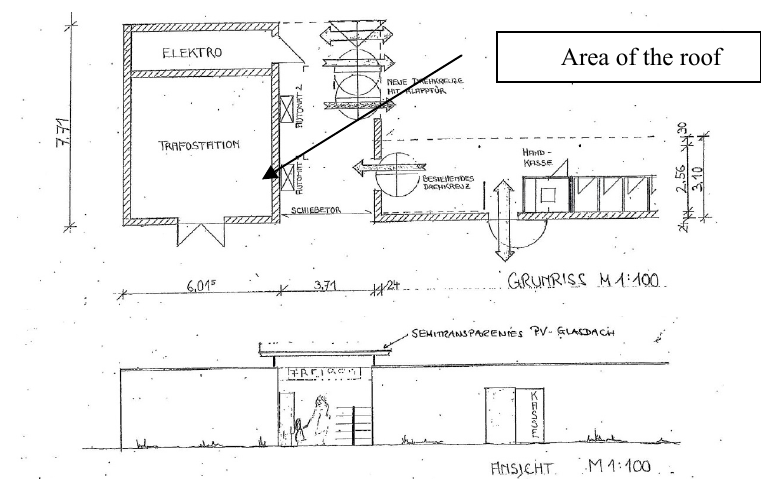
Figure 16: Solar roof in Haar